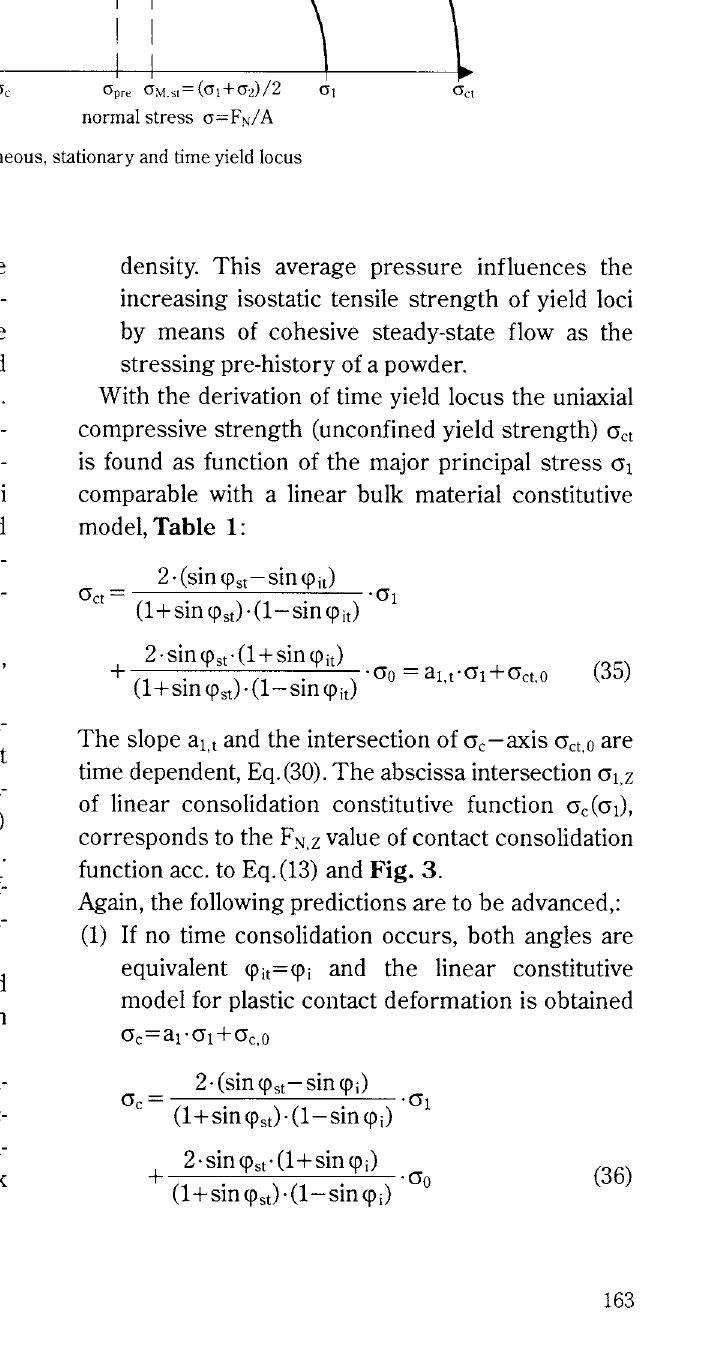
Characteristics of instantaneous, stationary and time yield locus